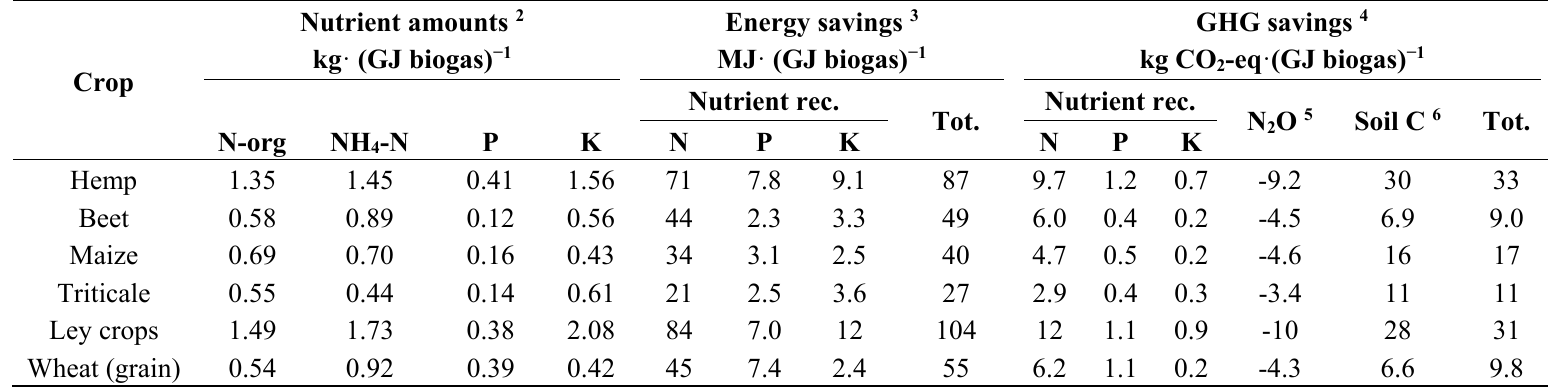
Table 5. Indirect savings of energy input and emissions of GHG’s when digestate replaces mineral fertiliser 1